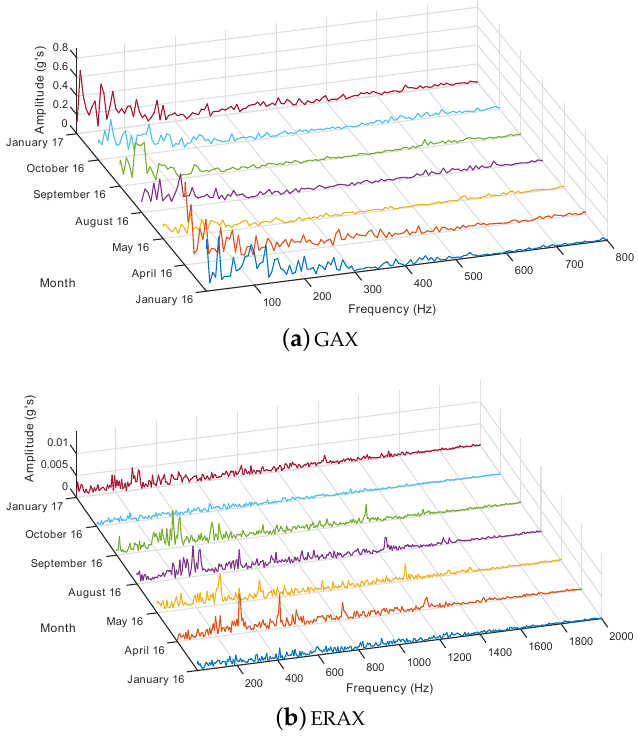
Figure 9. January 2016–January 2017. Evolution of envelope spectra at sub-synchronous speed.